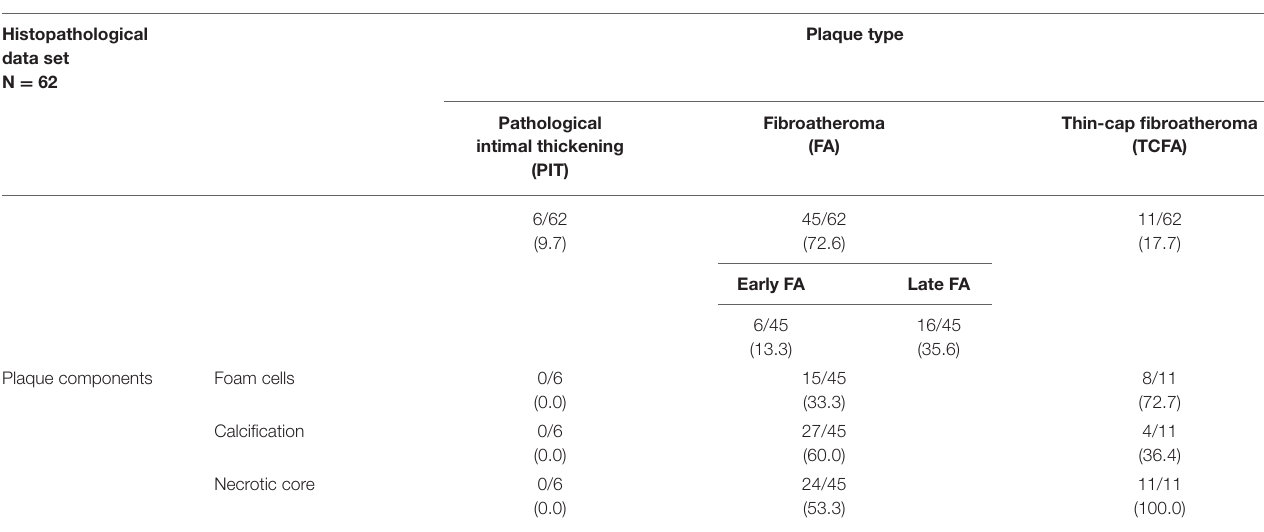
TABLE 1 | Histopathological data set ( n = 62 histopathology